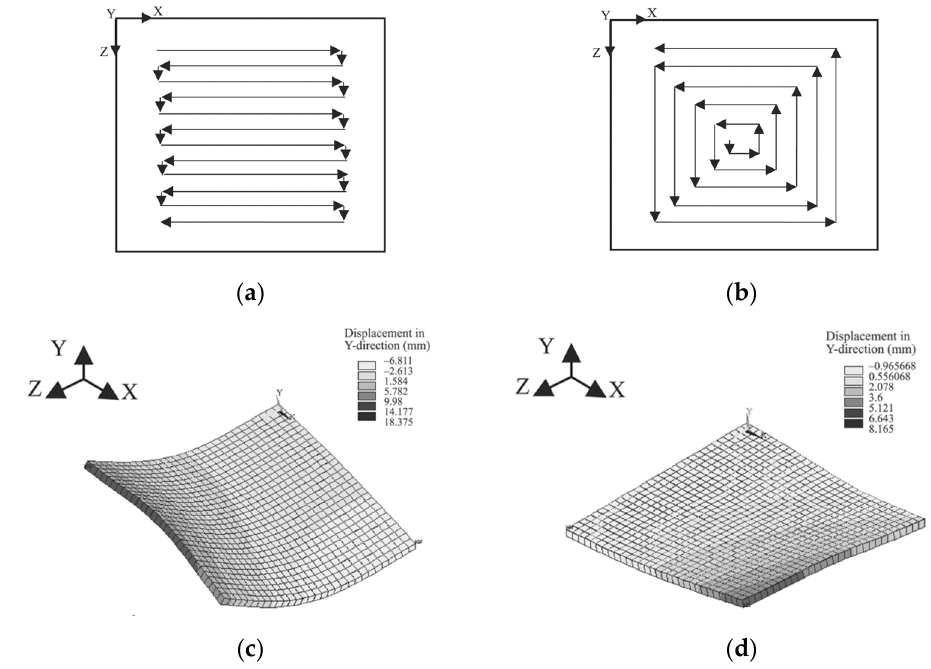
Figure 34. ( a ) Bi-directional and ( b ) offset-out deposition strategies and ( c , d ) the corresponding modeled deformation caused by residual stress (reproduced with permission from [161]; Copyright © 2002 Emerald Publishing Limited).